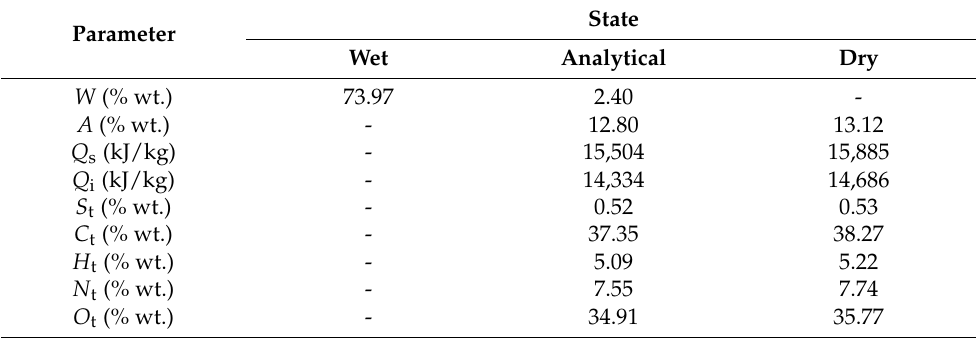
Table 2. Results of technical and elemental analyses and the combustion heat and calorific value of the poultry manure samples